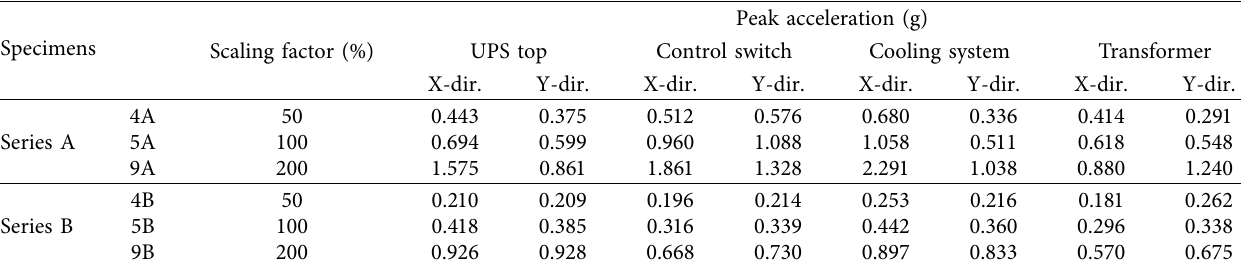
Figure 13: Acceleration response time histories of the test specimens in Series A and B of the AC156_50 test. (a) At the top of the UPS. (b) At the control switch. (c) At the cooling system. (d) At the transformer. Table 5: Peak accelerations of the test specimens in Series A and B at different